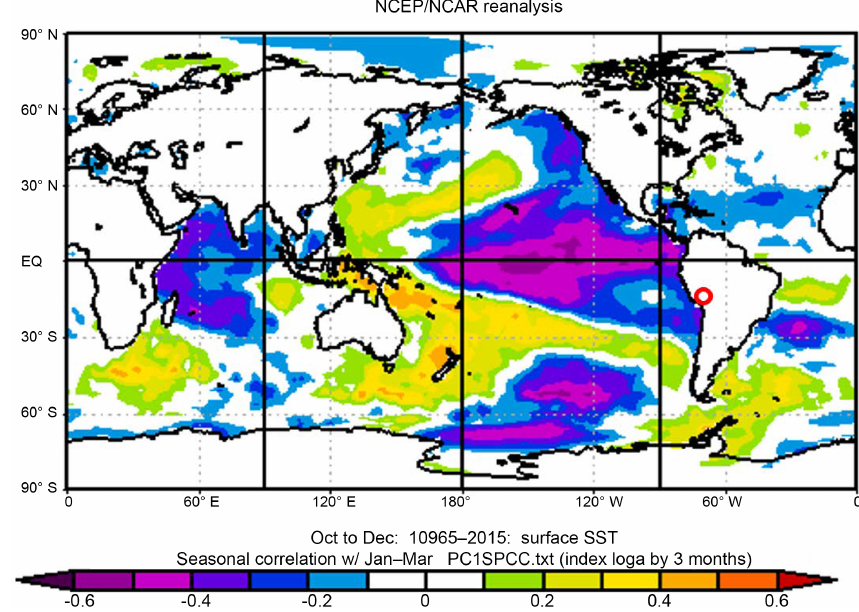
Figure 7. Correlation between global OND SST and first PC of regional JFM precipitation. Study region identified with red